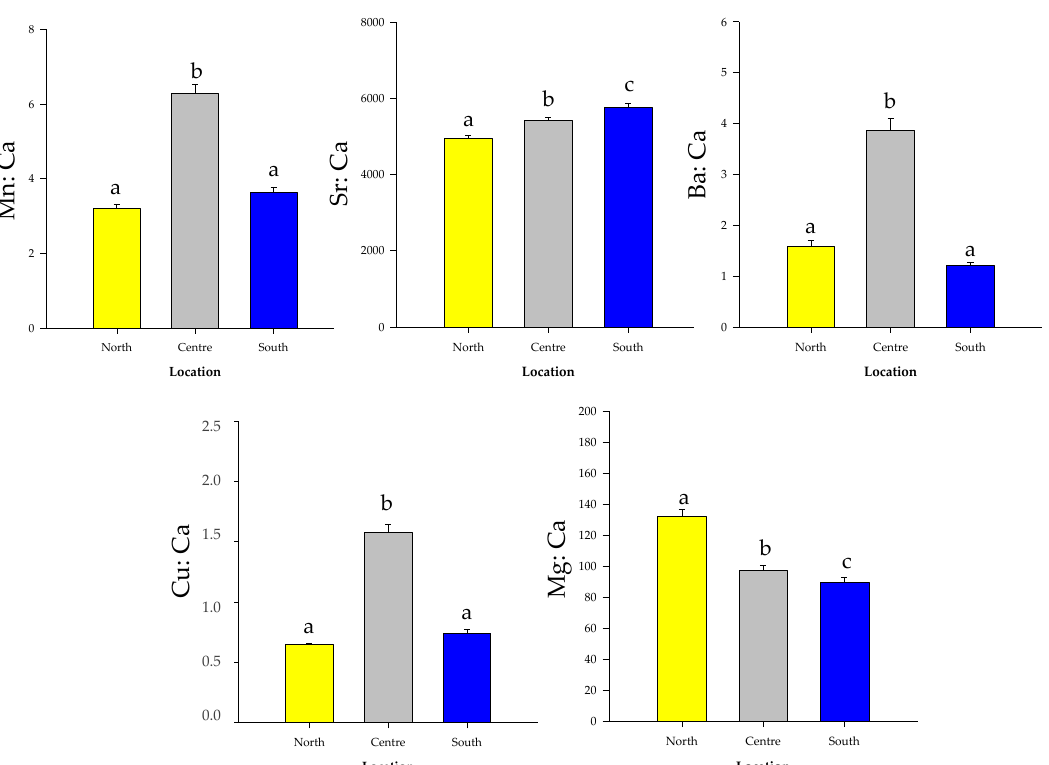
sampling locations (yellow line: North; grey line: Center; blue line: South). Figure 4. Average shape of otolith contour extracted from elliptical Fourier descriptors of the three